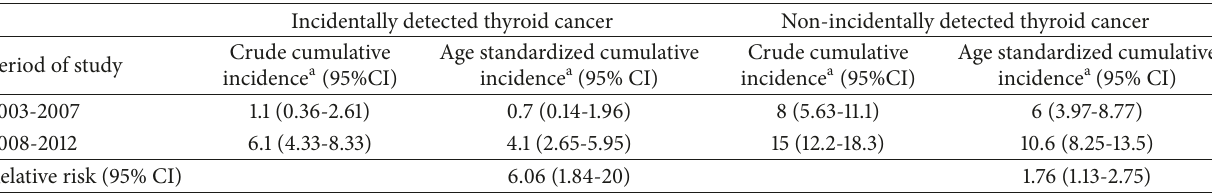
Table 3: Risk analysis of incidentally and non-incidentally detected thyroid cancer between periods of study in members of the PSHI (2003-